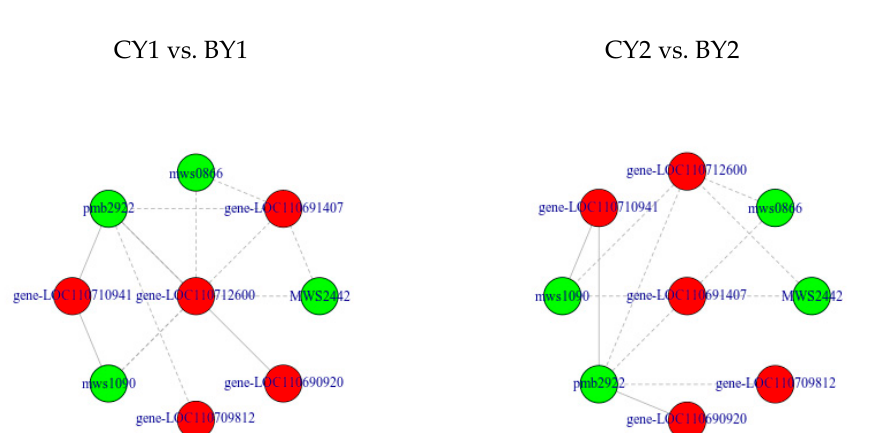
Figure 4. Correlations between genes and differential metabolites: Correlation network diagram, where metabolites are marked in green and genes in red, with solid lines representing positive correlations and dashed lines representing negative correlations.